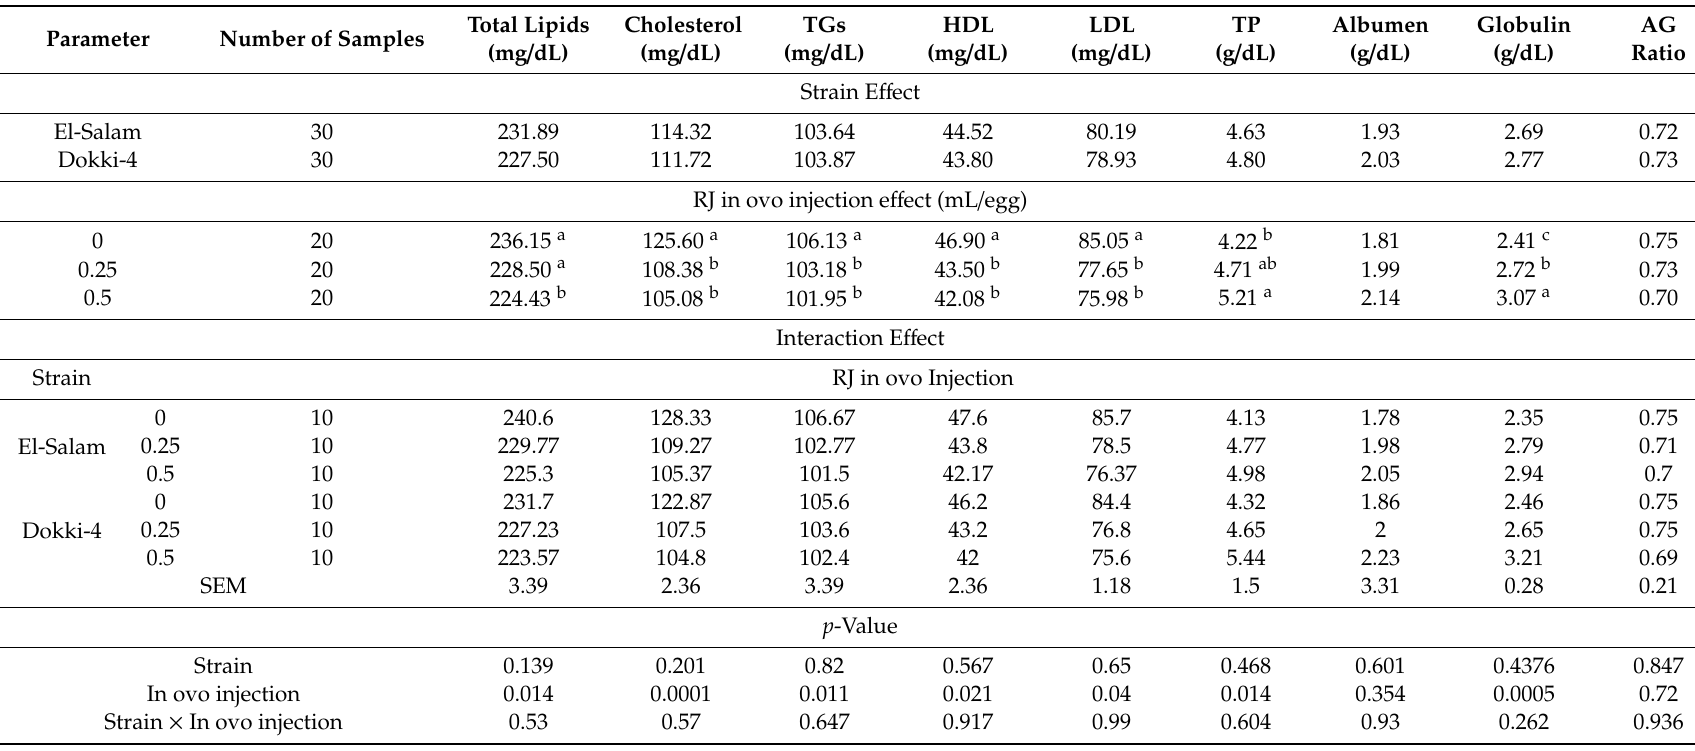
Table 3. E ff ect of in ovo injection of royal jelly (RJ) at two levels (0.25 and 0.5 mL / egg) on the serum lipid and protein profiles of two chicken strains (El-Salam and Dokki-4) compared to control saline injection (0 mL RJ / egg) and the interaction between strain and treatment